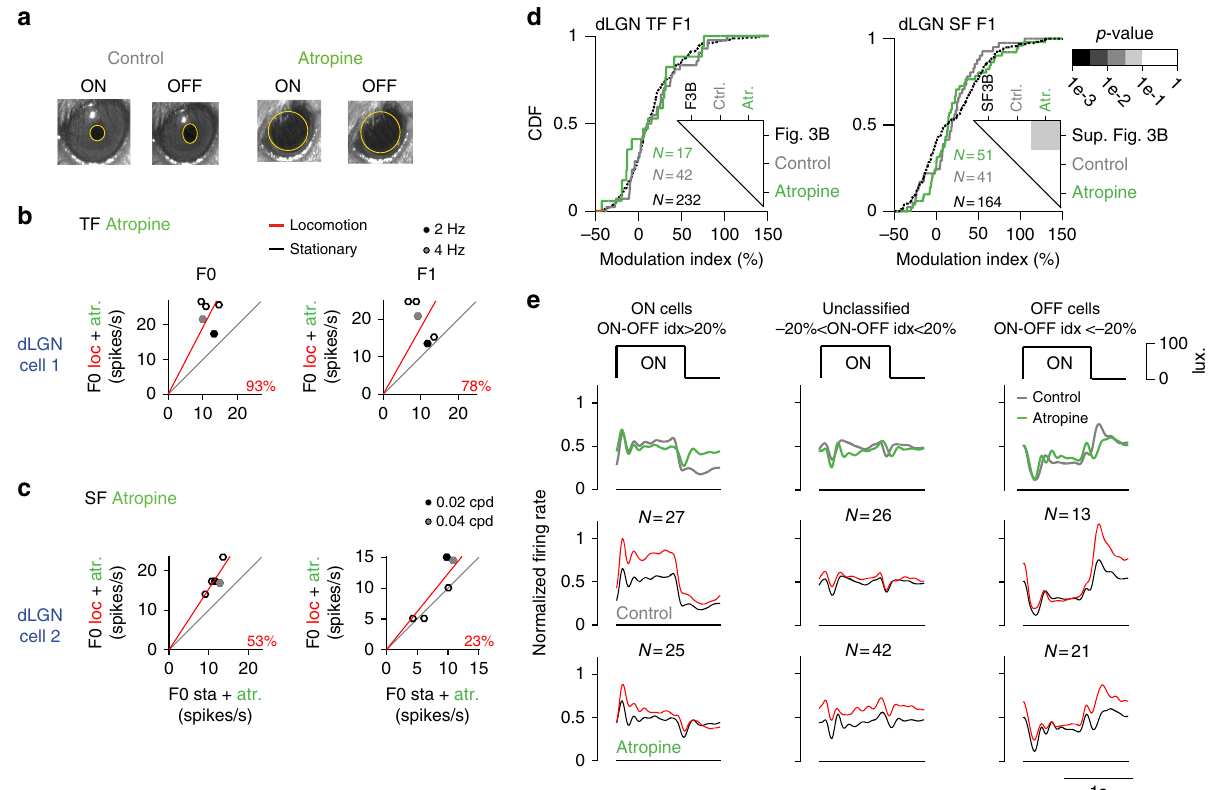
Fig. 9 dLGN response modulations following atropine application. a Pupil diameter without (black, ON cycle/OFF cycle, left/right) and with (green) atropine recorded in the same animal (separate sessions). b Mean fi ring rate (F0) and response (F1) amplitude of an example cell in stationary vs. locomotion trials for fi ve different temporal frequencies measured with atropine (93% increase in fi ring rate: 78% increase in response amplitude). High modulations by locomotion are independent of pupil diameter. c Same as b but for spatial frequencies (53% increase in fi ring rate; 23% increase in response amplitude). d Response (F1) modulation index of cells in Fig. 3g, h (black-dashed, N = 232 cells), control (gray N = 42 cells) and with atropine (green, N = 51 cells) to the temporal frequency stimulus (left). Response (F1) modulation index of cells in Supplementary Fig. 3g-h (black-dashed, N = 164 cells), baseline (gray, N = 41 cells) and under atropine (green, N = 51 cells) to the spatial frequency stimulus (right). P -values are shown in the inlet ( K – S test). e Superimposed responses of neurons in the three groups ( N = 4 mice; ON, unclassi fi ed and OFF) from the same animals with (Atropine) and without (Control) atropine application (top row) to full- fi eld contrast reversal stimulus. Population mean of locomotion (red) and stationary (black) responses for the control group (middle row, baseline: ON cells: N = 27, unclassi fi ed cells: N = 26, OFF cells: N = 42). Population mean of locomotion (red) and stationary (black) responses for the atropine group (bottom row, baseline: ON cells: N = 25, unclassi fi ed cells: N = 42, OFF cells: N =